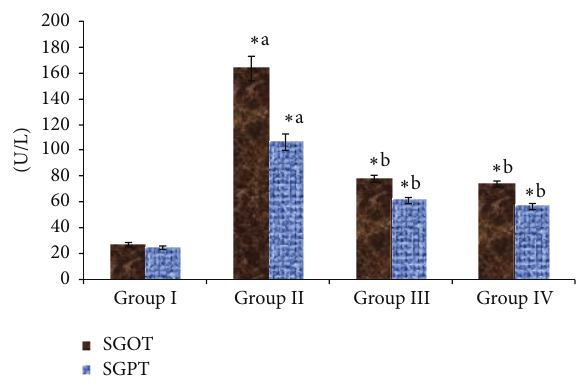
Figure 2: Effect of ethanolic extract of Triticum aestivum on the SGOT and SGPT levels in STZ-induced model. Values are the mean ± SD for six animals in each group. Values are statistically significant at ∗ P < 0.05; statistical significance was compared within the groups as follows. a Diabetic rats were compared with normal rats. b Glibenclamide and Triticum aestivum treated diabetic rats were compared with diabetic rats.